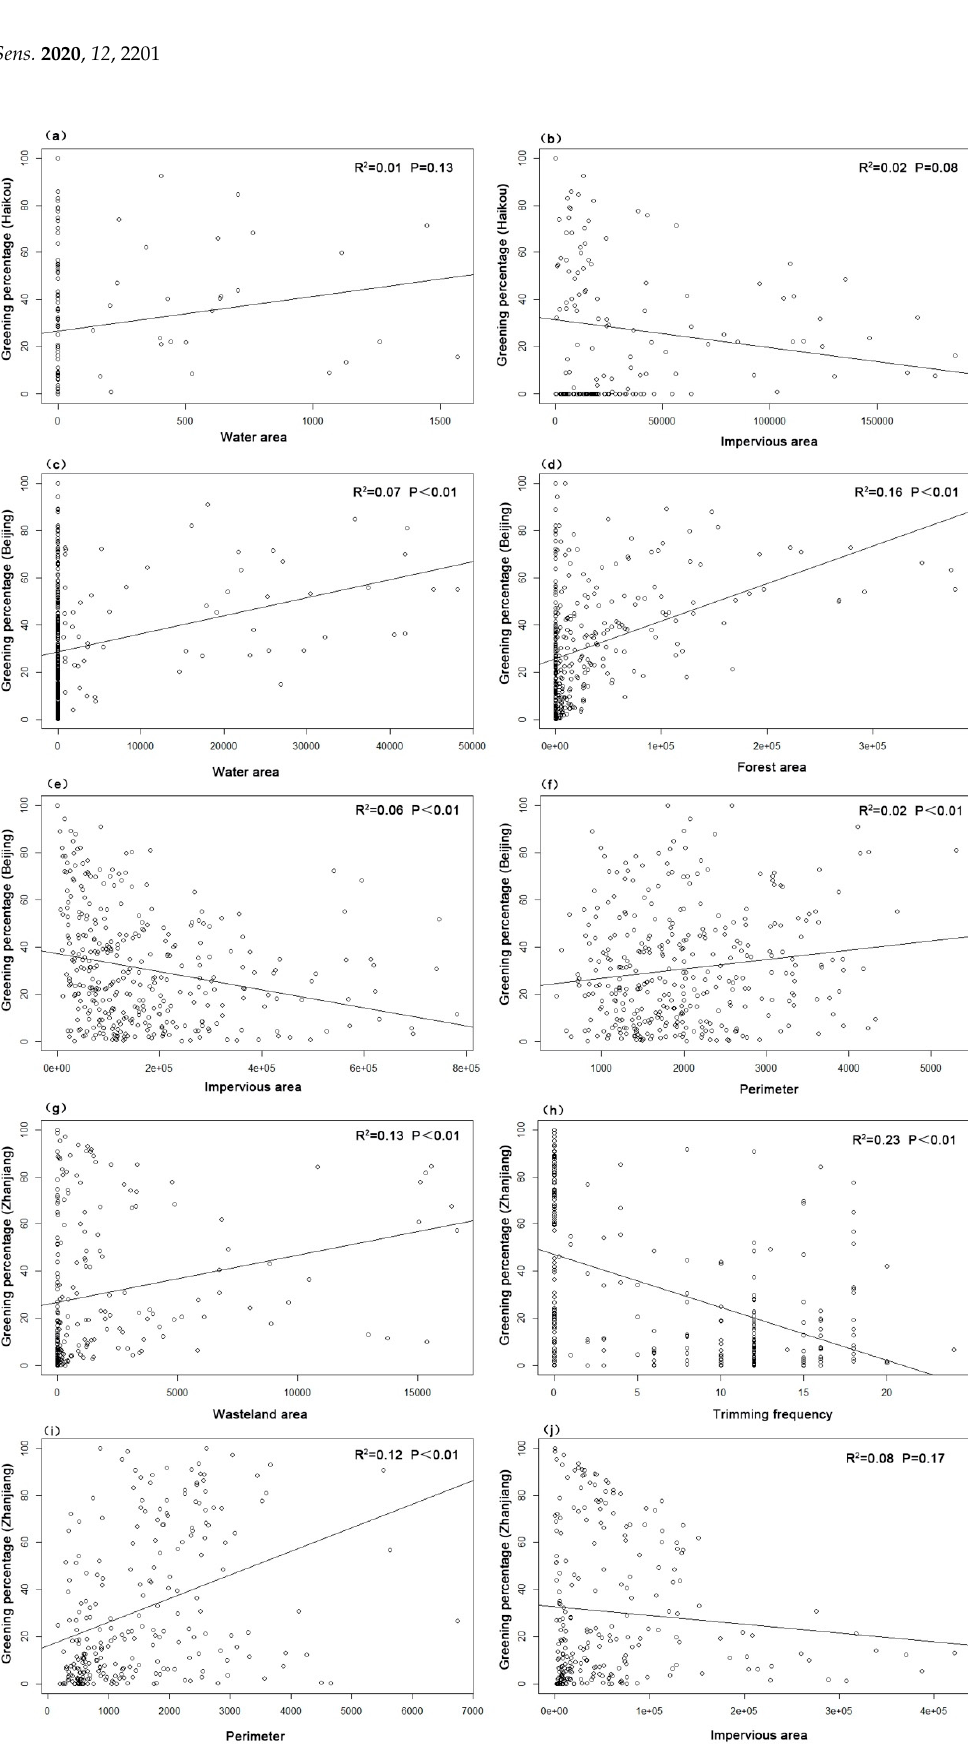
Figure 9. Scatterplots depicting the correlations between greening percentages and impervious area, wasteland area, trimming frequency, and perimeter within Haikou, Beijing, and